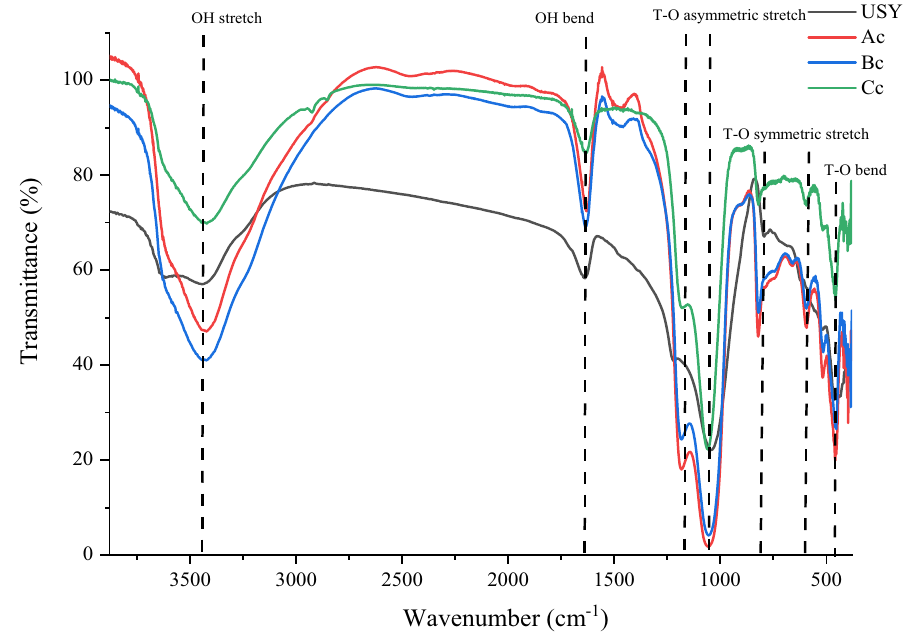
Figure 3: FTIR spectra of catalysts after the calcination process.